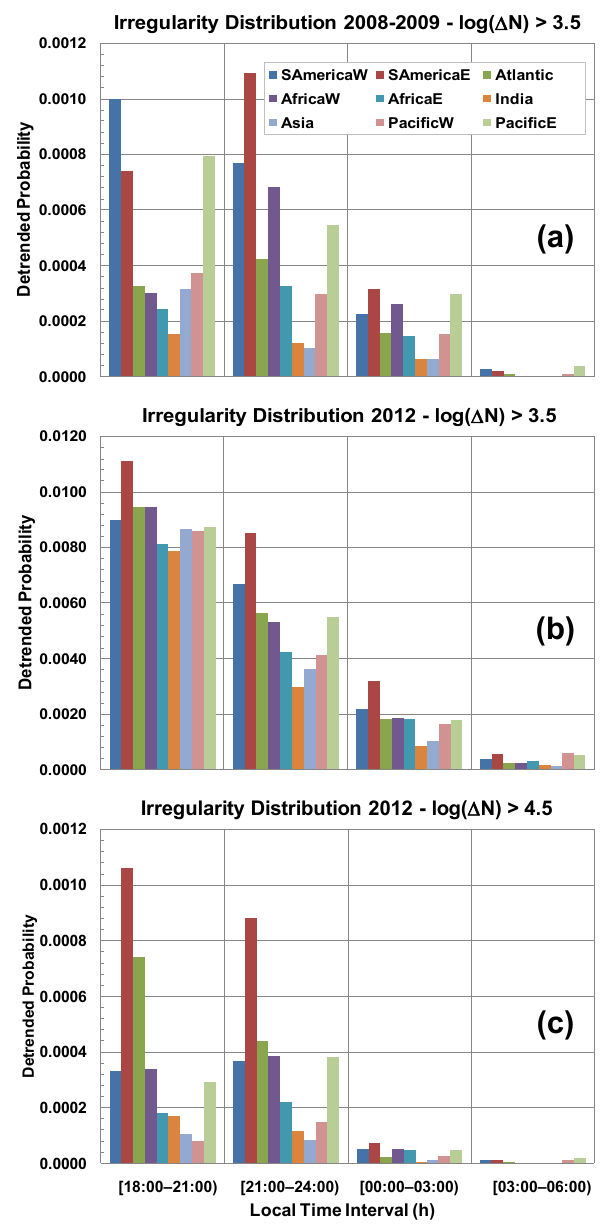
Figure 8. Detrended probability distributions of N as functions of local time intervals and longitude sectors for (a) 2008–2009 and log( N ) > 3.5; (b) 2012 and log( N ) > 3.5; (c) 2012 and log( N ) >4.5. The smallest probabilities that meet the criteria for statistical significance are associated with the Atlantic longitude sector and the local time interval [03LT, 06 LT) in panel (a) and the Pacific West longitude sector and the local time interval [03 LT, 06 LT) in panel (c), respectively. rates (Atlantic and African West sectors) or the fastest rate (Asian